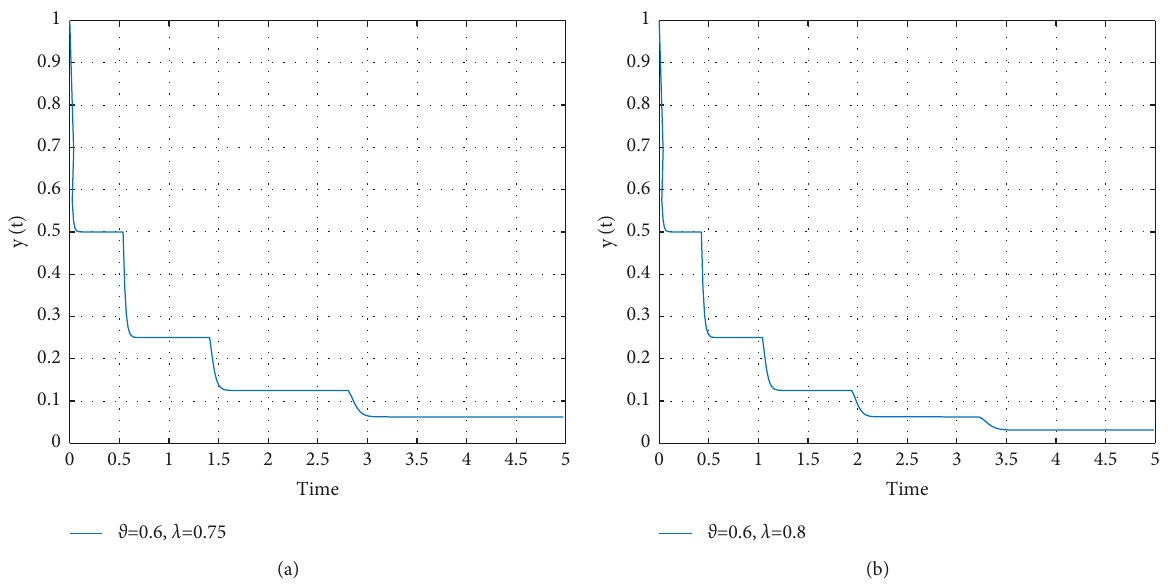
ϑ =0.6, λ Figure 5: Numerical simulations of model (36) with ϑ � 0 . 6, with λ � 0 . 75 (a), λ � 0 . 8